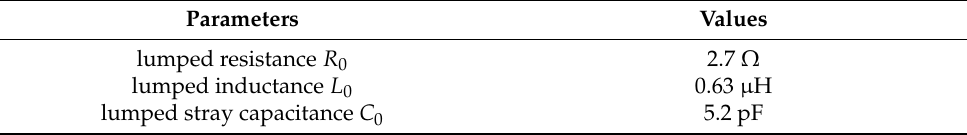
Table 2. Lumped parameters of the coil. Parameters Values lumped resistance R 0 2.7